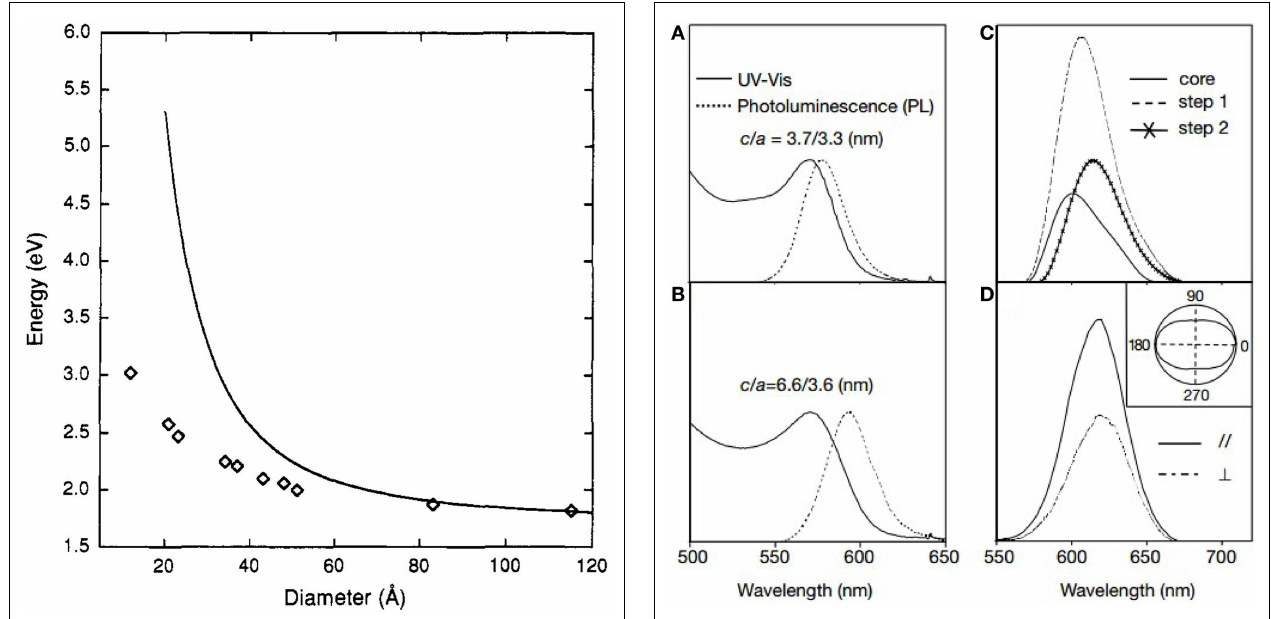
FIGURE 11 |Transition energy of CdSe crystallites as a function of size (diamonds) compared with the prediction of the effective mass approximation (solid line; Murray et al., 1993) .